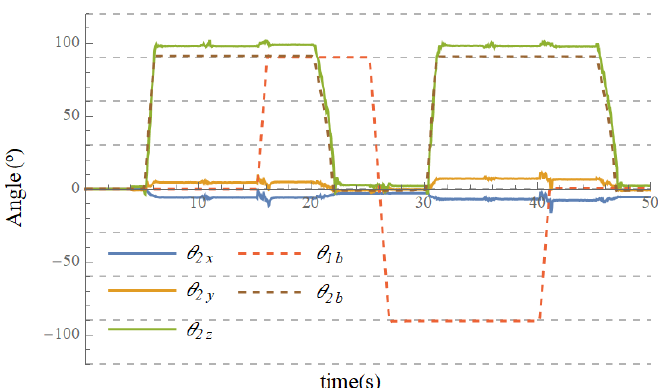
Figure 8. Evolution of Rotation Vector 2 when testing the link model using only accelerometer